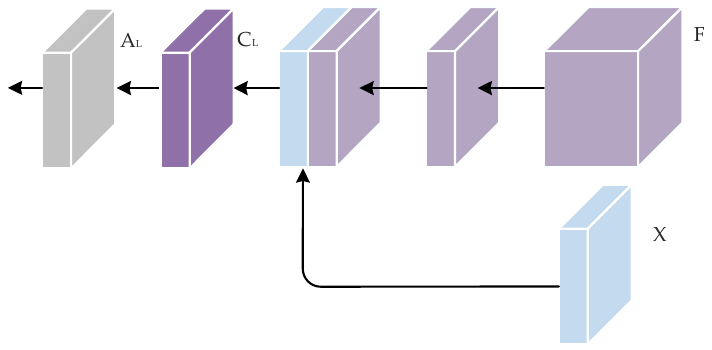
Figure 2. Local-level context module.